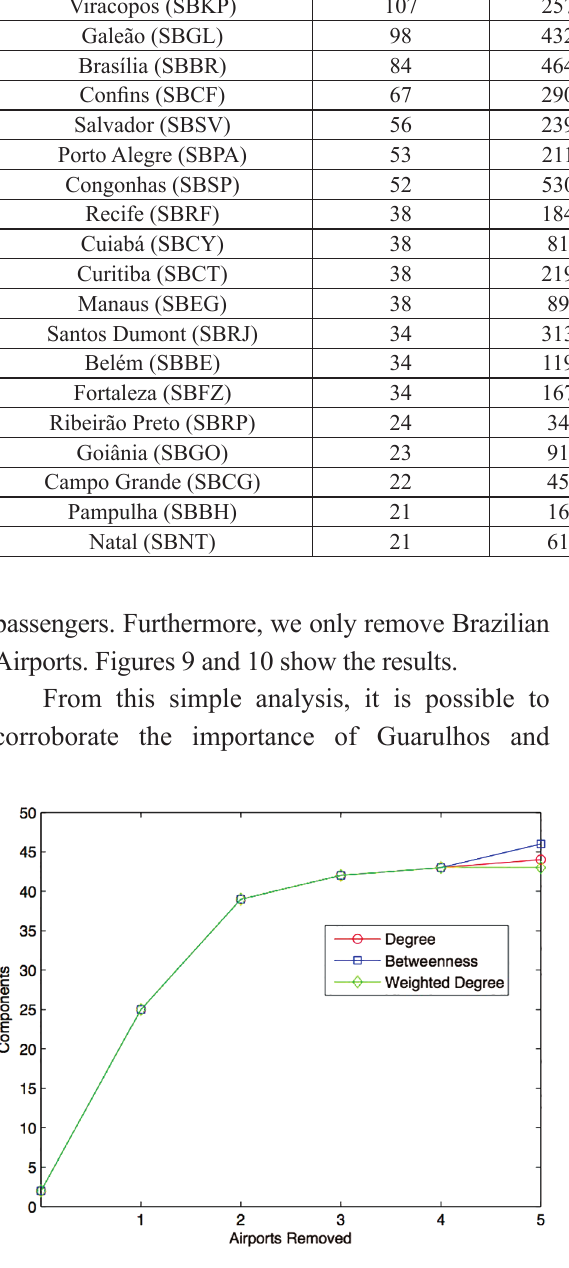
Figure 9 - Changes on the number of components by the total number of removed airports. For interpretation of the references to color in this figure, the reader is referred to the web version of this article.